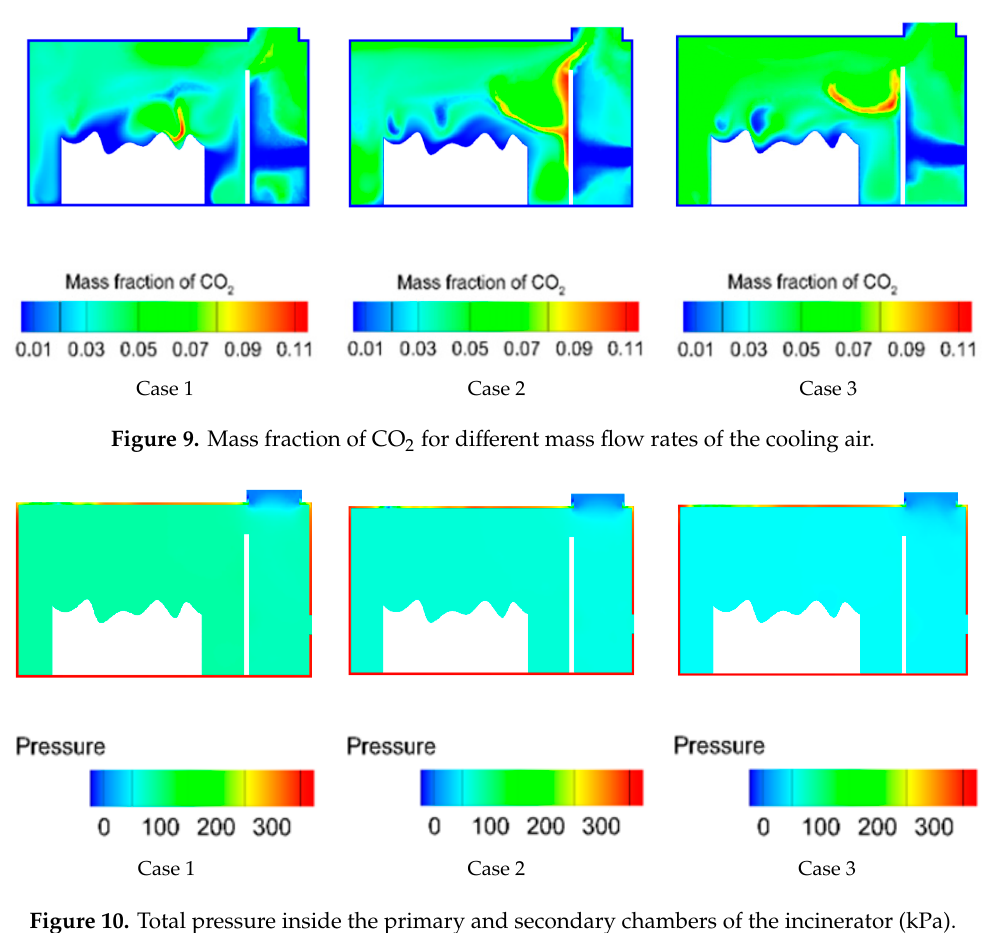
Figure 10. Total pressure inside the primary and secondary chambers of the incinerator (kPa).